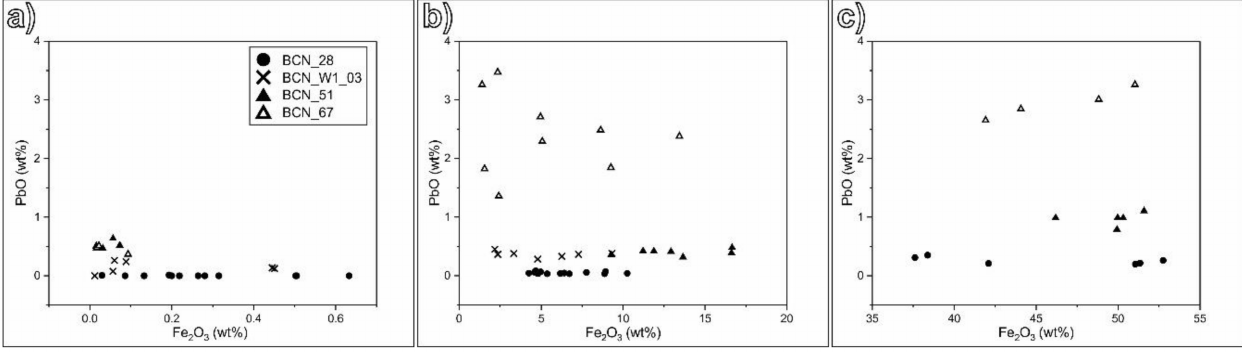
Figure 12. Scatterplots of Fe 2 O 3 vs. PbO concentrations obtained through punctual EMP-WDS measurements on the selected samples: ( a ) values obtained in the uppermost portions of the finishing plasters; ( b ) values obtained in the paint layers; ( c ) values obtained in the pigment